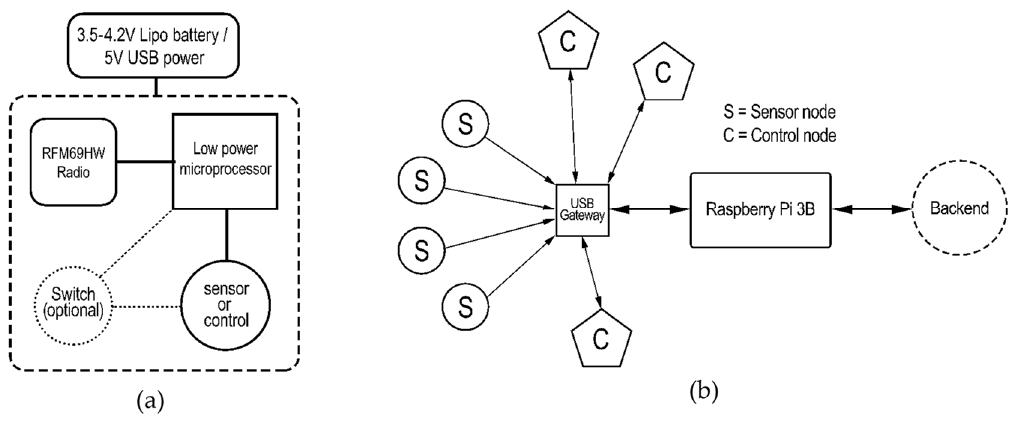
Figure 1. ( a ) Block diagram illustrating components in a basic wireless sensor/control node, ( b ) network architecture of a typical wireless sensor network.